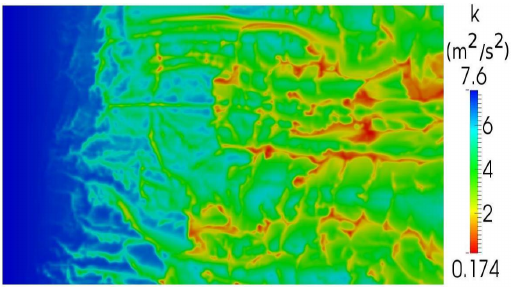
Figure 12. Turbulence kinetic energy distribution at 30 m.